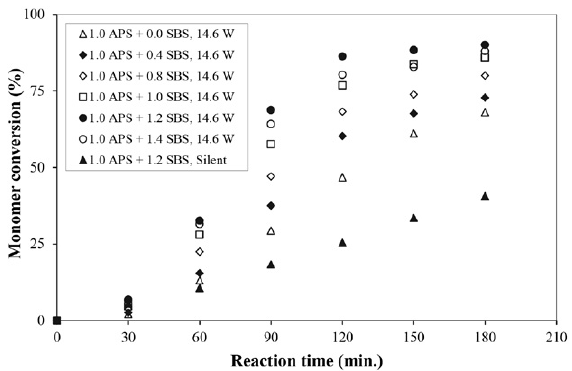
Fig. 1. The effect of molar APS/SBS ratios on the monomer conver-